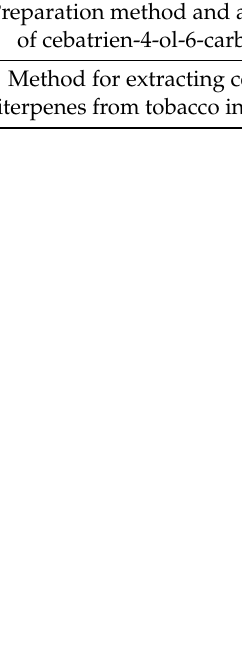
Table 2. Potential lead compounds derived from α -CBD and β -CBD. Table 2. Potent ial lead compounds derived from α - CBD and β -CBD. Table 2. Potent ial lead compounds derived from α - CBD and β -CBD. Table 2. Potent ial lead compounds derived from α - CBD and β